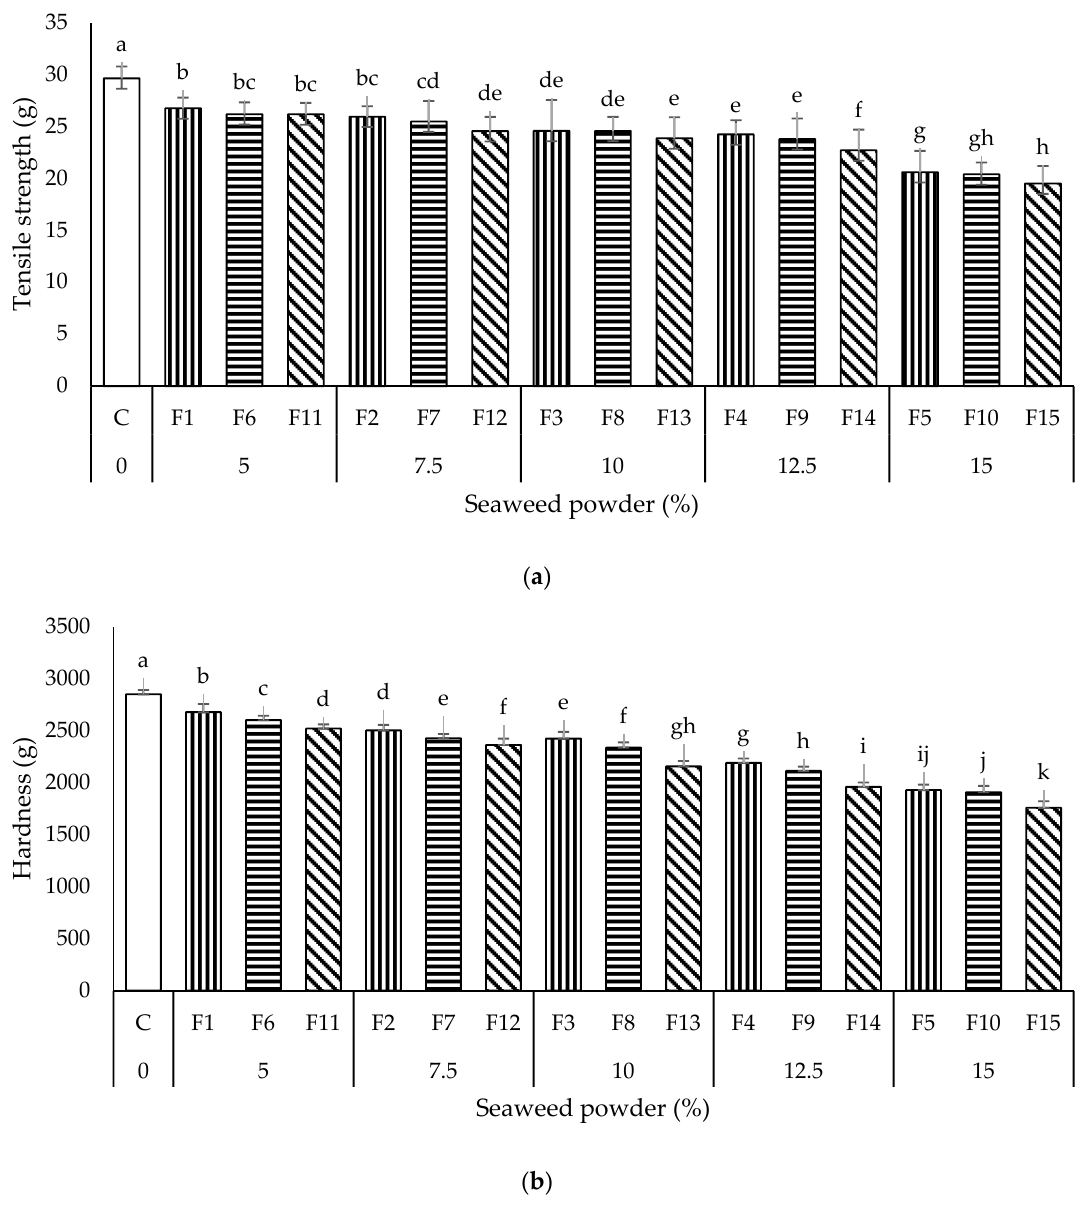
Figure 2. Texture properties ( a ) tensile strength and ( b ) hardness of all the noodles samples. Data are presented as mean ± standard deviation ( n = 3). a–k with different superscripts indicate the significant difference among the noodles samples (Tukey’s HSD, p < 0.05). Bars with vertical, horizontal, and diagonal patterns = wheat flour: potato starch ratios of 9:1, 8:2, and 7:3, respectively.